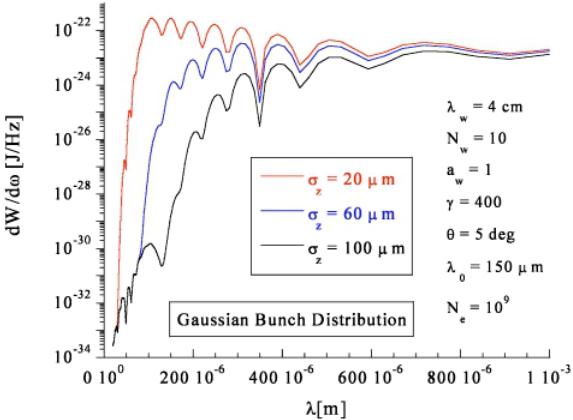
FIG. 8. (Color) Energy spectra for different bunch lengths of a Gaussian-shaped electron beam.